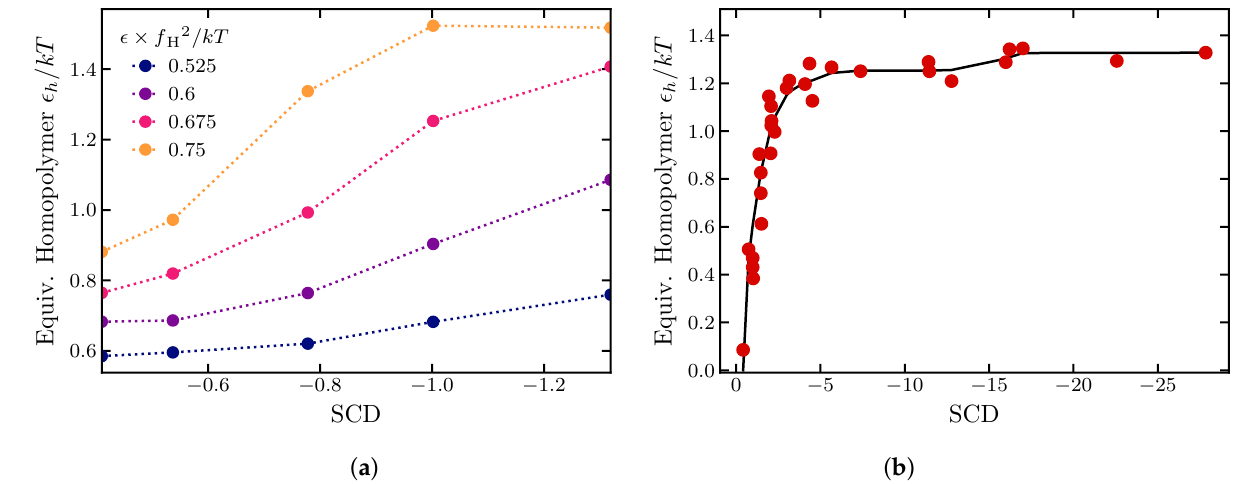
Figure 5. Equivalent homopolymer model. ( a ) Cohesiveness (cid:101) h of the effective homopolymer model that reproduces the radii of gyrations of sequences with cohesiveness (cid:101) shown in Figure 3 and Table 1, as a function of their SCD. ( b ) Cohesiveness (cid:101) h of the effective homopolymer model that reproduces the R g / R k ratio of the sequences composed of 25 positively and 25 negatively charged monomers shown in Figure 4, as a function of their SCD value. The red dots show the individual correspondence for each sequence based on Figure 3. The black line is the smoothed isotonic regression R g / R k vs. SCD; see